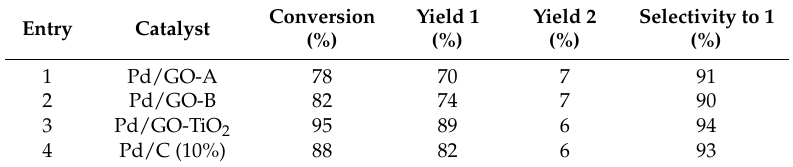
Table 1. The carbonylative Suzuki–Miyaura reaction with GO-supported palladium a .